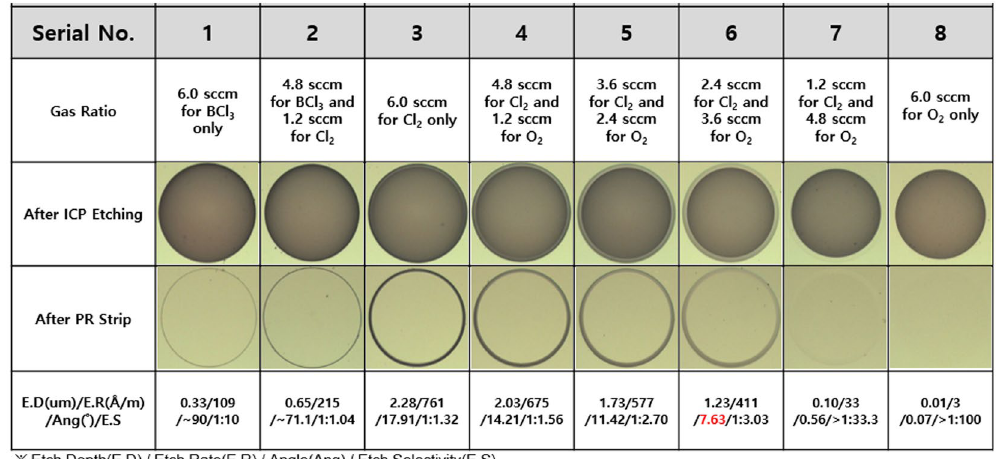
Figure 5. ICP etching profiles for different BCl 3 , BCl 3 + Cl 2 , Cl 2 , and Cl 2 + O 2 gas ratios. As indicated, a high etching depth of 1.23 µ m and a low etching profile angle (up to 7.63 °) can be achieved using Cl 2 gas (2.4 sccm) in